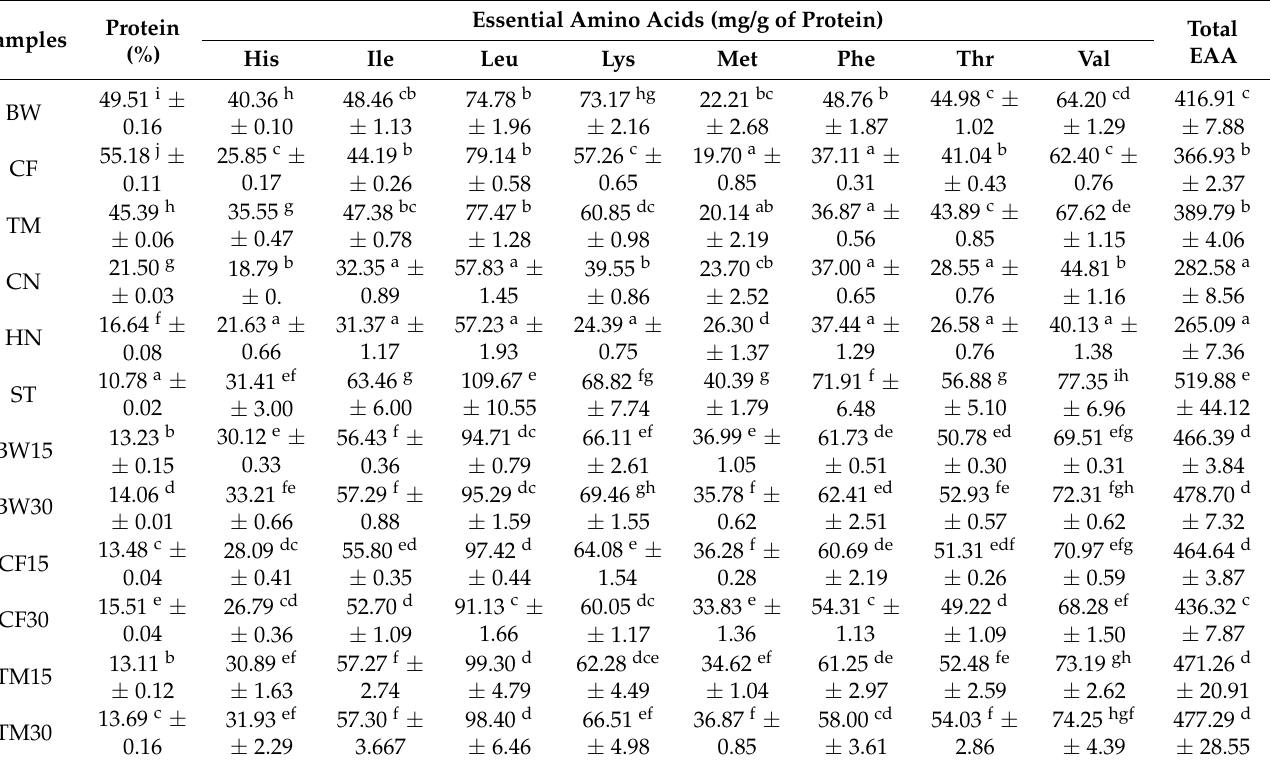
Table 2. Amino acid profile of raw materials and enriched